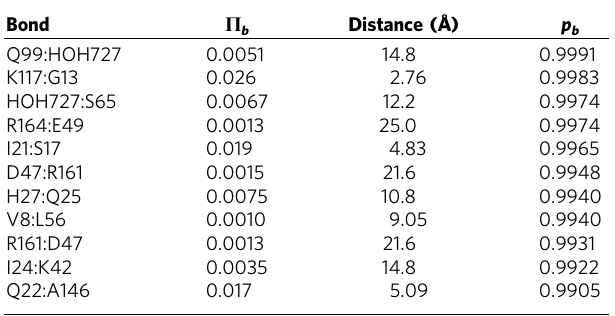
Table 3 | Top bonds by quantile score in h-Ras.